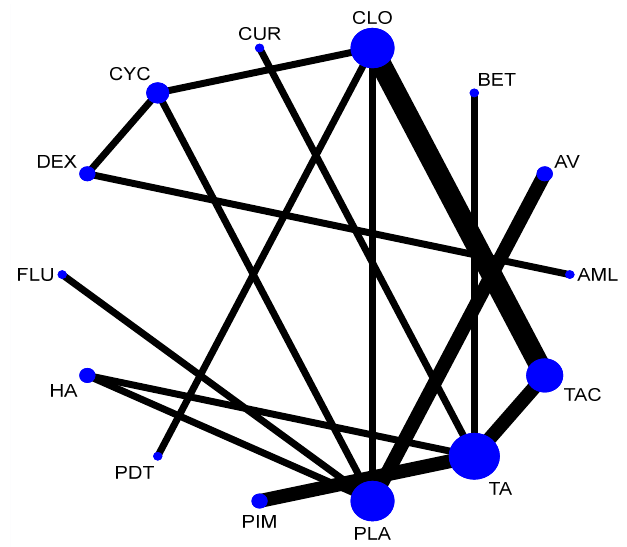
Figure 20. Network plot: Clinical Score (subgroup analysis). Abbreviations: AML, amelexanox paste; AV, aloe vera; CUR, curcumin gel; PDT, photodynamic therapy; PLA, placebo; PUR, purslane; TAC, tacrolimus; FLU, flucinonide acetonide; CLO, Clobetasol propionate; PIM, pimecroli ‐ mus; BET, betamethasone; TA, triamcinolone acetonide; DEX, dexamethasone; CYC, cyclosporine.